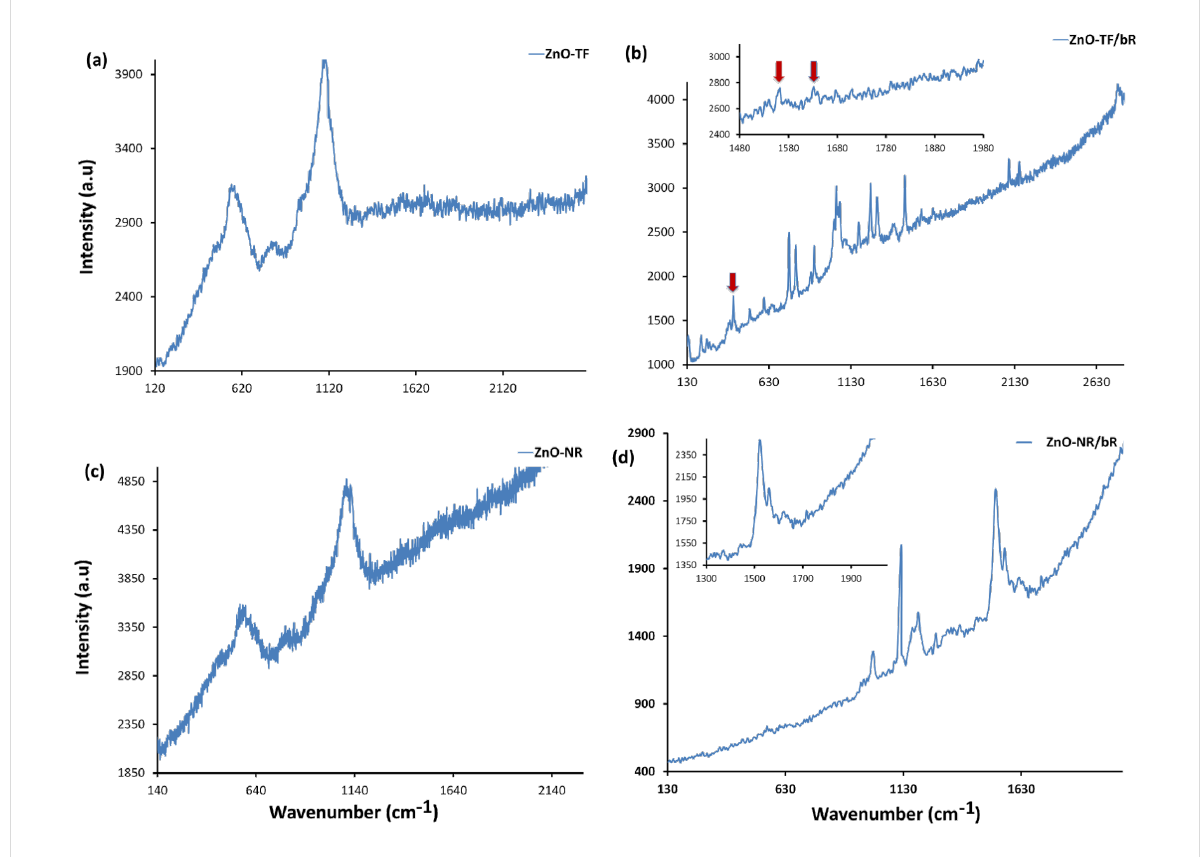
Figure 5: Raman spectra. (a) ZnO-TF shows the characteristic peaks for ZnO at 467 cm − 1 , 563 cm − 1 and 800 cm − 1 ; (b) ZnO-TF/bR hybrid structure showing characteristic peaks of both ZnO and bR, indicating the preservation of the functional properties of the protein. Inset image shows amide I and amide II peaks of bR protein. (c) ZnO-NR structure illustrates the major ZnO vibrational peaks at 476 cm − 1 , 570 cm − 1 , 806 cm − 1 and 1106 cm − 1 . (d) ZnO-NR/bR hybrid structure. Inset image shows specific amide I and amide II peak of bR protein.